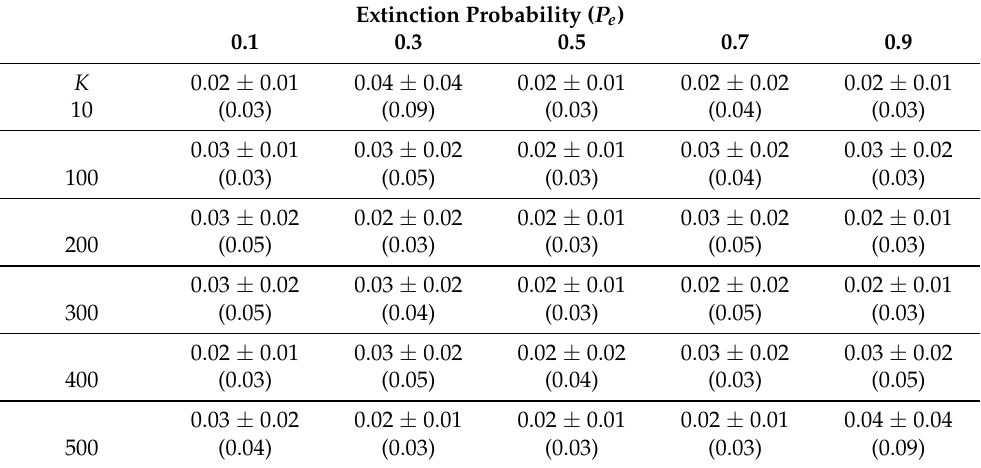
Table 8. Fitness results of SDEP with targeted extinction on Griewank ( K is the stagnant counter and fitness threshold T = 0.5); 95% confidence interval is presented after ± sign, and standard deviation is presented inside parenthesis.